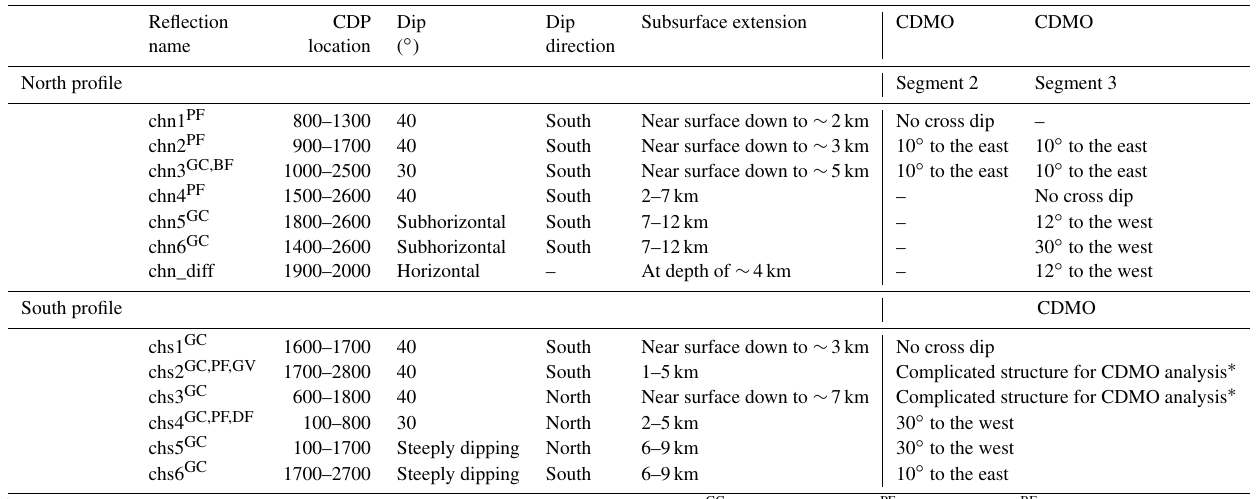
Table 3. Geometrical attributes of reflections imaged in the Chibougamau